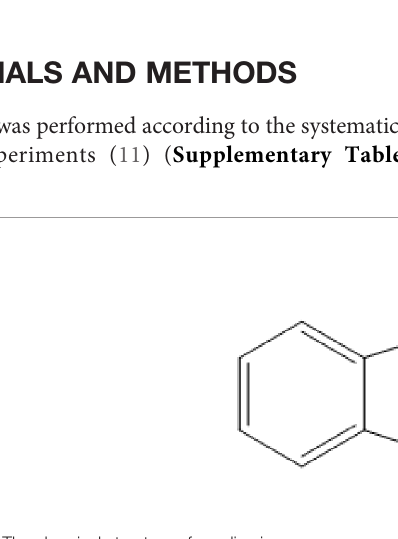
FIGURE 1 | The chemical structure of